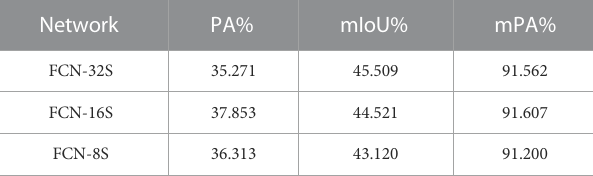
TABLE 2 The accuracy evaluation indicators of the test